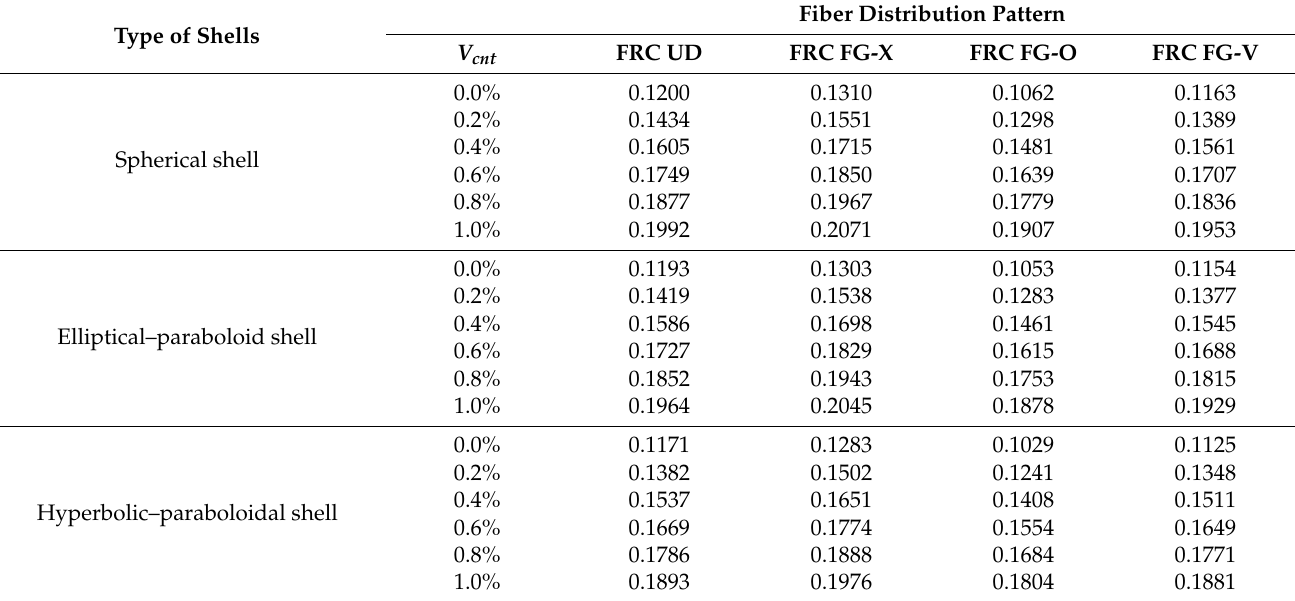
Table 8. The volume fraction of the CNTs was proposed as V cnt = 1%, whereas the minimal further reinforced the composite plate; therefore, the dimensionless frequencies increased. Table 8. The effect of the volume fraction and distribution patterns of the fibers on the dimensionless frequency of cross-ply F/CNT-RC shells (SSSS, b / a = 1, a / h = 10, N = 9, V cnt = 0.01, V f